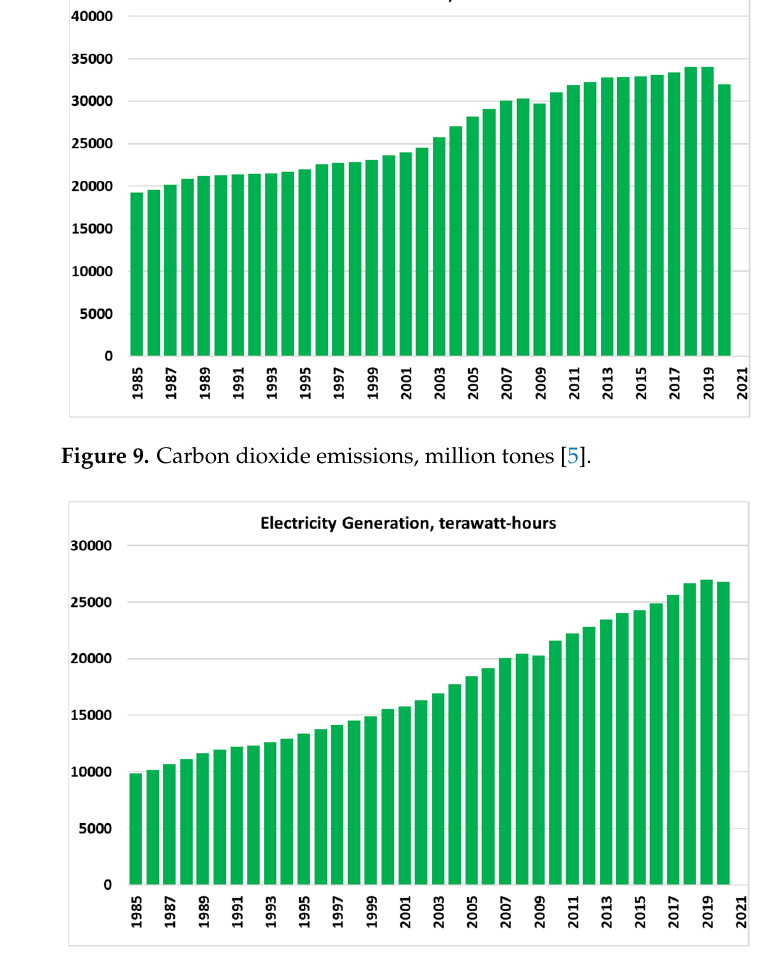
Figure 10. Electricity Generation, terawatt-hours [5].